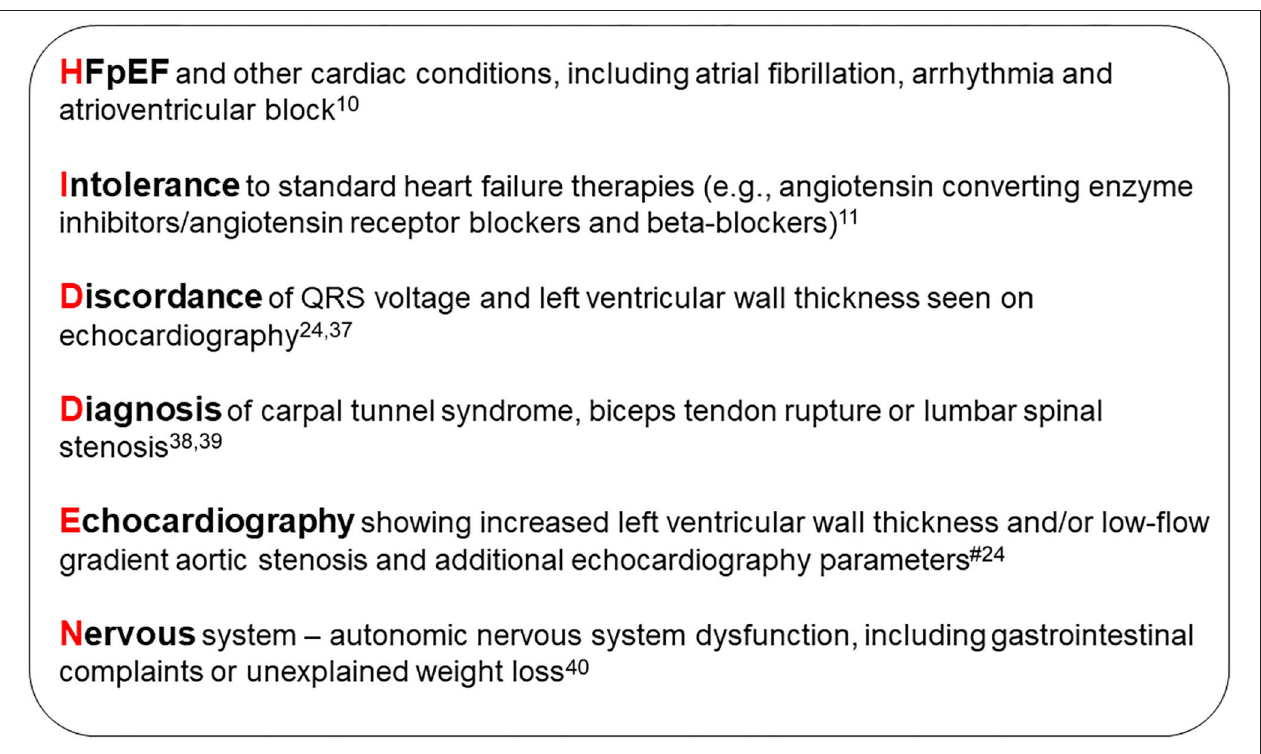
FIGURE 1 | HIDDEN mnemonic. # Echocardiographic, speckle-strain and tissue doppler “red flags”: Heart failure normal or mid-range ejection fraction; increased wall thickness; left atrial enlargement; low stroke volume index; low-flow, low-gradient aortic stenosis (Stage D2); low myocardial contraction fraction; advanced diastolic dysfunction; impaired global longitudinal strain with apical sparing; low mitral annular tissue Doppler S’ (average septal and lateral annulus) (24). HFpEF, heart failure with preserved ejection fraction. in case of negative biopsy with high clinical suspicion